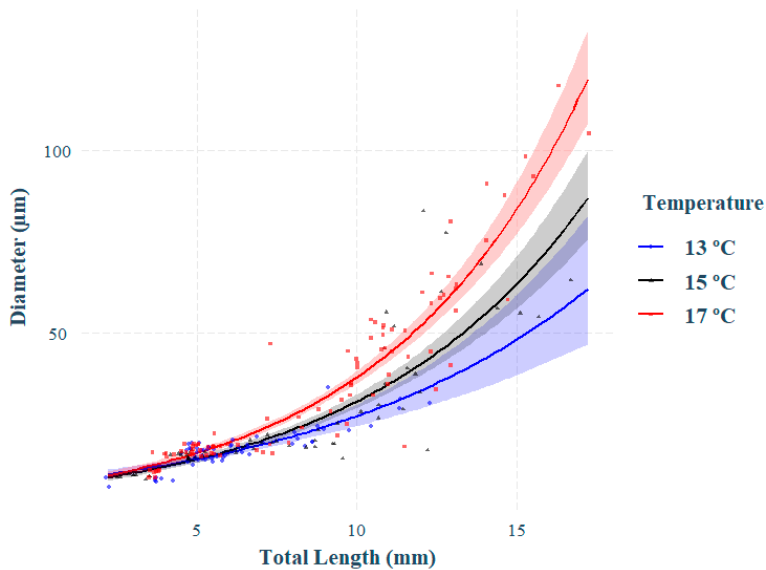
Figure 4. Relationship between otolith diameter ( μ m) and total length (mm) of European sardine Sardina pilchardus (Walbaum, 1792) larvae reared from 0 to 25 days post ‐ hatching (dph) at 13, 15, and 17 °C. Results of the GLMs are presented in Table 1.